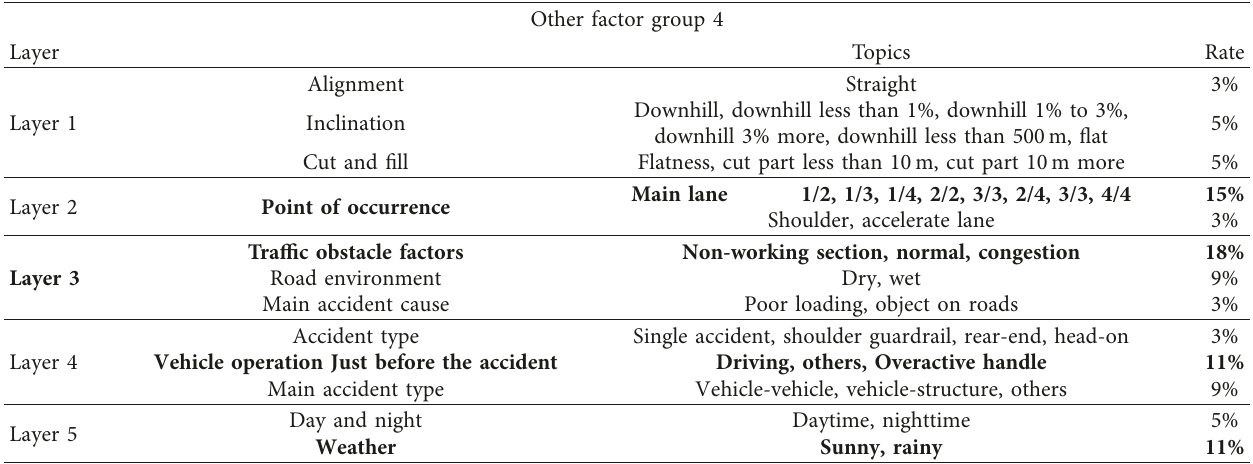
Table 12: Other factor topic modeling group